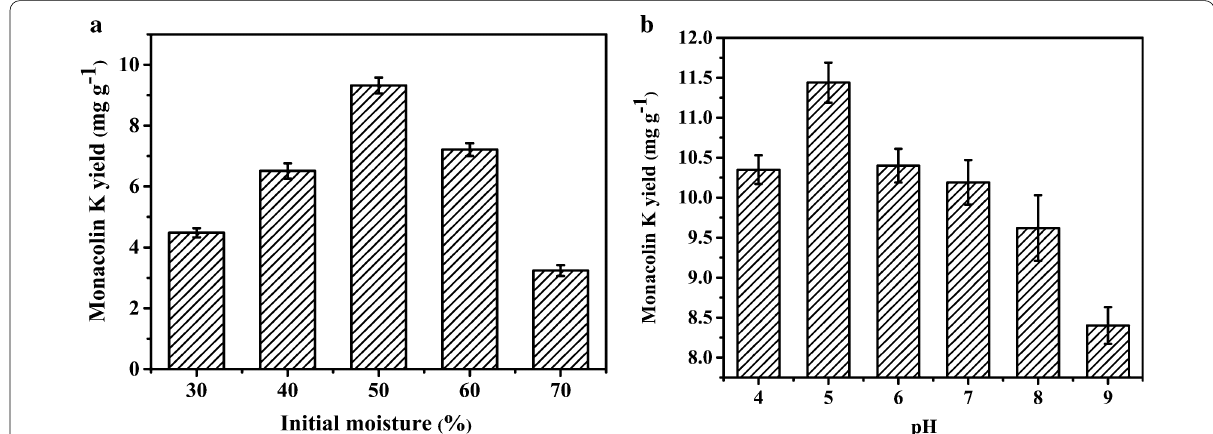
Fig. 1 Influences of initial moisture ( a ) and pH ( b ) on the production of Monacolin